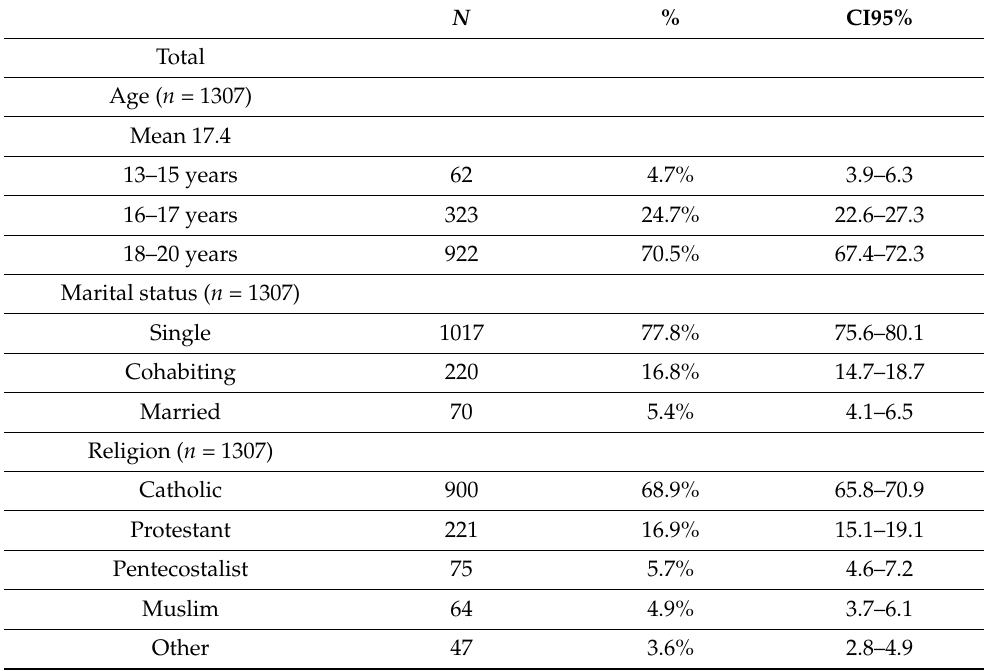
Table 1. Sociodemographic characteristics of the study